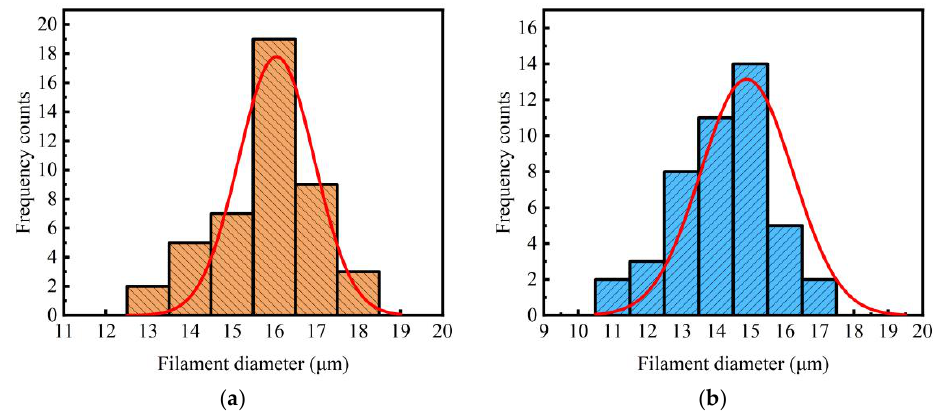
Figure 8. Distributions of the filament diameters: ( a ) initial state; ( b ) immersed in 4 mol/L NaOH solution at 70 °C for 6 h.